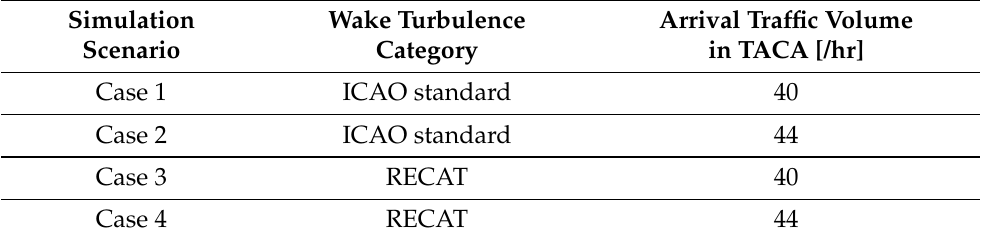
Table 8. Combination of wake turbulence category and arrival traffic volume.